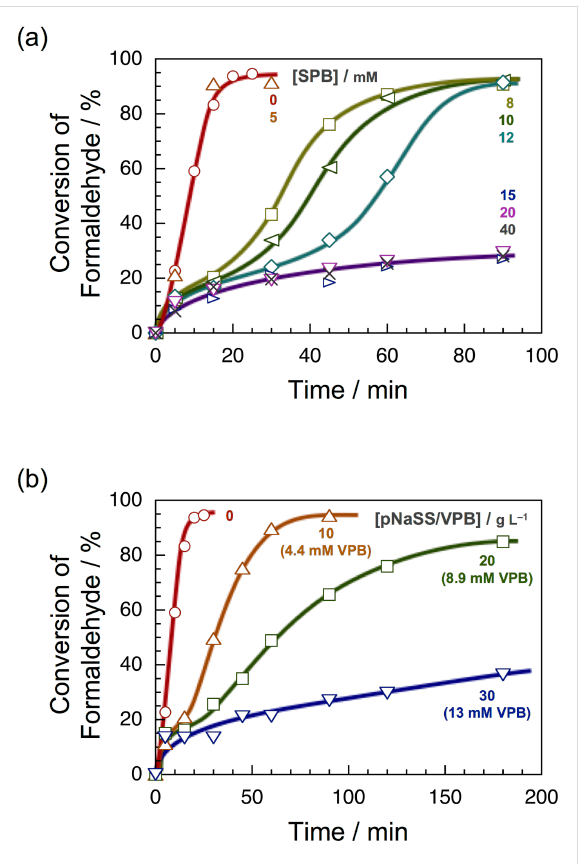
Figure 1: Time–conversion plots for the formose reaction using 200 mM formaldehyde, 20 mM calcium hydroxide, and 6.9 mM cocata- lyst in the presence of SPB (a) and pVPB/NaSS (b); fructose and glyc- eraldehyde was used as a cocatalyst for SPB and pVPB/NaSS, re- spectively. The curves are drawn as a guide for the